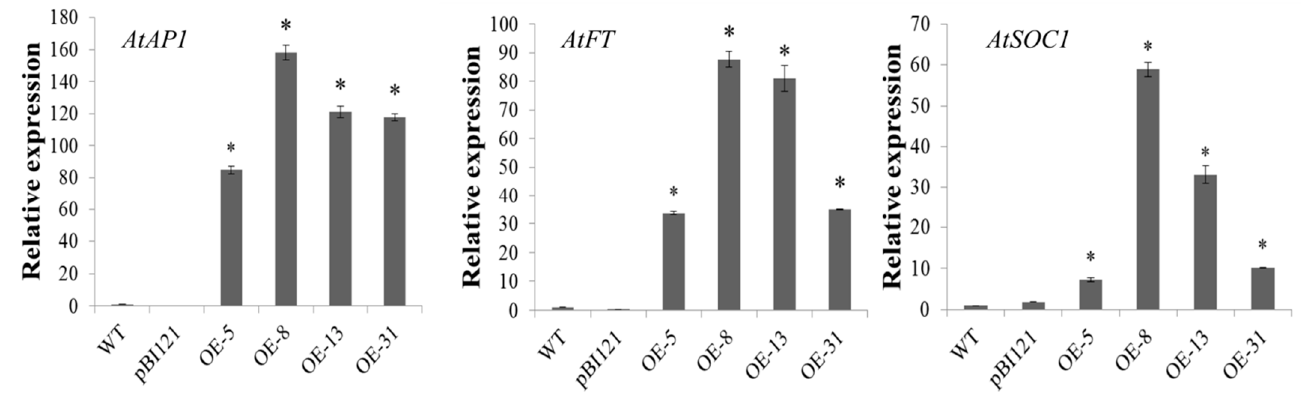
Figure 5. Expression of the flowering-related genes AtAP1 , AtFT , and AtSOC1 verified by qRT–PCR in transgenic and control lines. Significant differences among the samples were assessed at the p < 0.01 level by Student’s t tests; asterisks (*) indicate samples significantly different from the wild type.